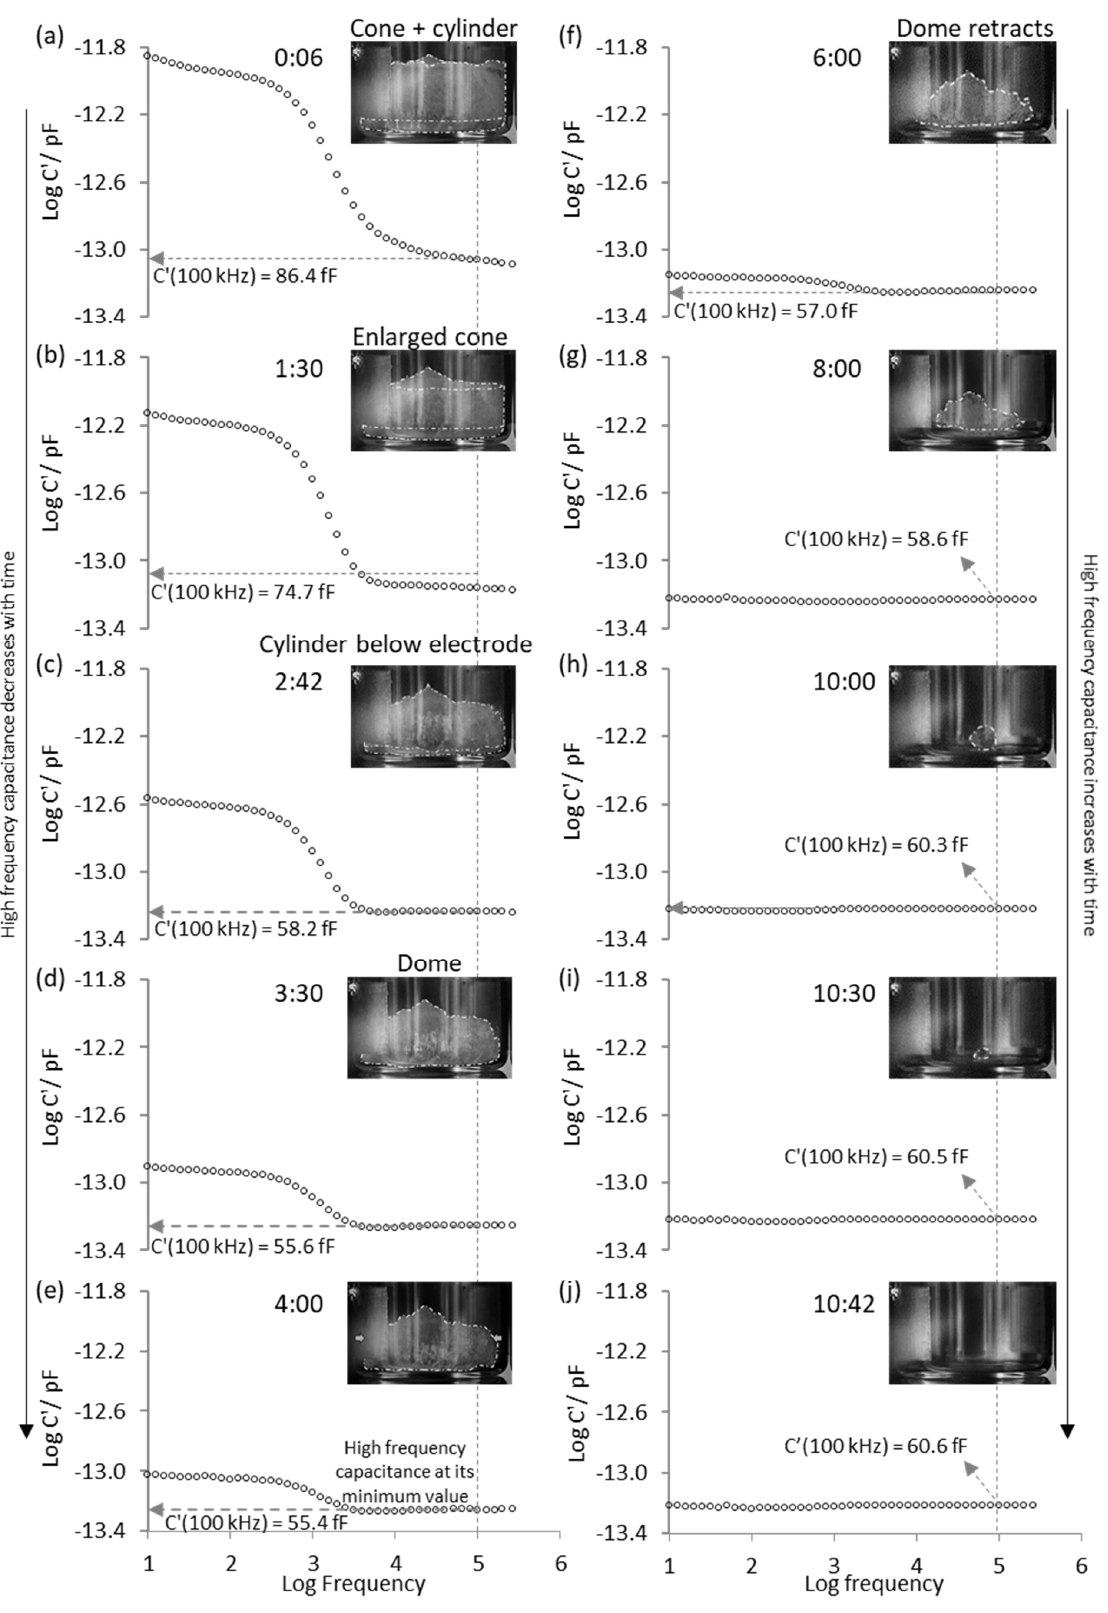
Figure 3. Bode plots ( a – j ) showing the real part spectra of ice contained in the TVIS vial with electrodes 10 × 19 mm (at 3 mm from the vial base) and the photographs of the sublimation front obtained at various time-points during primary drying. Features of the time profile of the C′(100 kHz) parameter during primary drying stage.